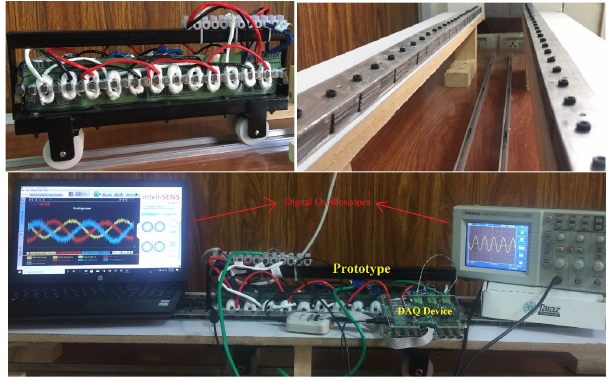
Figure 13. HELFSM prototype and test